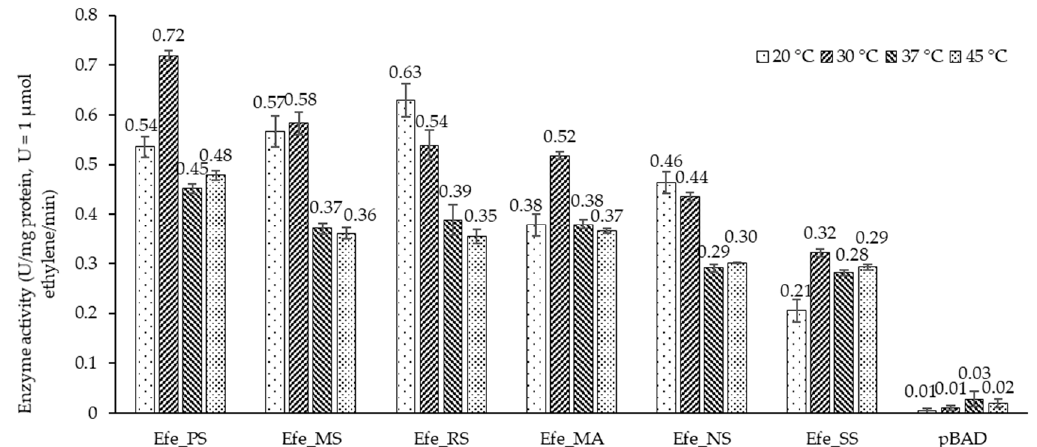
Figure 8. Ethylene production activity in vitro for 12 h at different temperature intervals from 20 ◦ C to 45 ◦ C (calculated by the conversion rate of AKG, 1AKG + 1ARG → 2 Ethylene). Table 2. Purification table for six purified ethylene forming enzymes, including specific and total enzyme activity. (U = 1 µ mol of ethylene produced per minute), corresponding yield and enrichment. Purified Protein Yield EnrichmentTotal